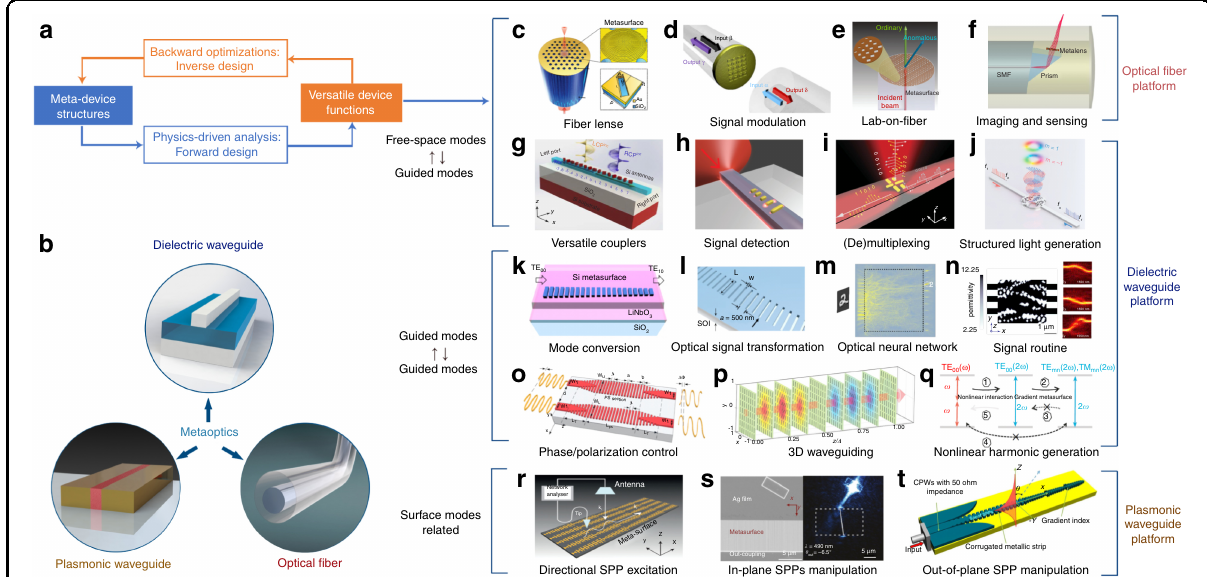
Fig. 1 Allying metasurfaces and metamaterials with different waveguide platforms for various photonic applications. a If classi fi ed by design method, meta-waveguides can be conceived either by physics intuition-based forward design or computer optimizations-based inverse design. b If categorized by waveguide platforms, meta-optics can be saddled with dielectric waveguides, optical fi bers and plasmonic waveguides. c – t Brief zoology of meta-waveguides. A plethora of applications are prototyped by the playground of meta-waveguides, including, for instance, metasurface-patterned dielectric waveguides 35 – 44,50 – 53,82 , forward-designed metamaterial waveguides 54 – 56,83 – 89 , metasurface- or metamaterial-hybrid optical fi bers 74 – 76,96 – 110 , meta-structures- assisted plasmonic waveguides 70 – 73,112 – 128 , inverse-designed metamaterial waveguides 47,57 – 69 and etc. 535,536 . Panels adapted from: De Gruyter ( c ) 100 ; Springer Nature ( d 96 , e 75 , f 74 , j 47 , k 51 , l 53 , p 535 , q 52 , r 70 , s 124 ); OSA ( g 44 , m 59 , n 58 , o 56 ); ACS ( h ) 37 ; AAAS ( i ) 50 ; AIP Publishing ( t ) 127